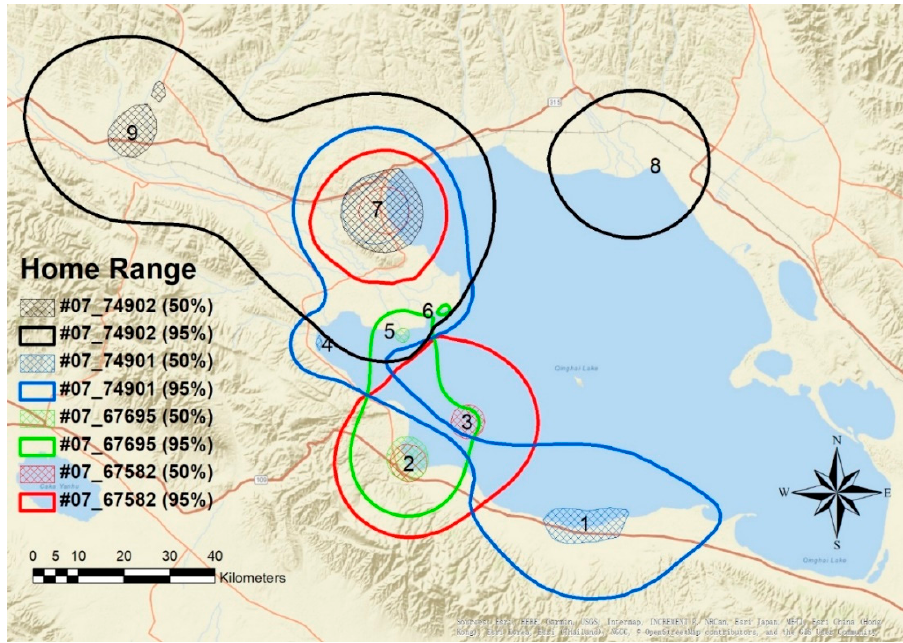
Figure 2. Home range (95% contour) and core area (50% contour) of four Bar-headed Geese ( Anser indicus ) captured in 2007 in Qinghai Lake (March-October) created using a Brownian Bridge Movement Model. Core areas and codes: 1. Jiangxigou, 2. Heimahe Estuary, 3. Sankuaishi Island, 4. Garila and Quanwan, 5. Shenhe Estuary, 6. Buhahe Estuary and Egg Island, 7. Hadatan, 8. Shaliuhe Estuary, and 9. Luonia.